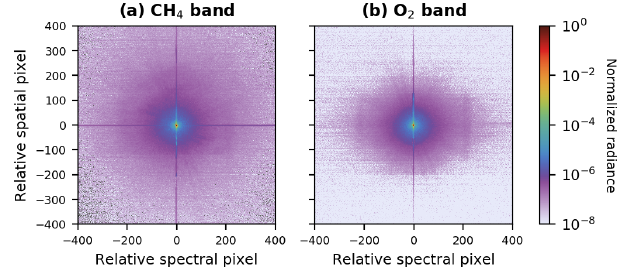
Figure 6. Median stray-light kernels for (a) CH 4 and (b) O 2 bands. Multiple merged frames were interpolated to a common spatial– spectral pixel grid before taking the median of all frames to produce the kernels for use in the stray-light correction